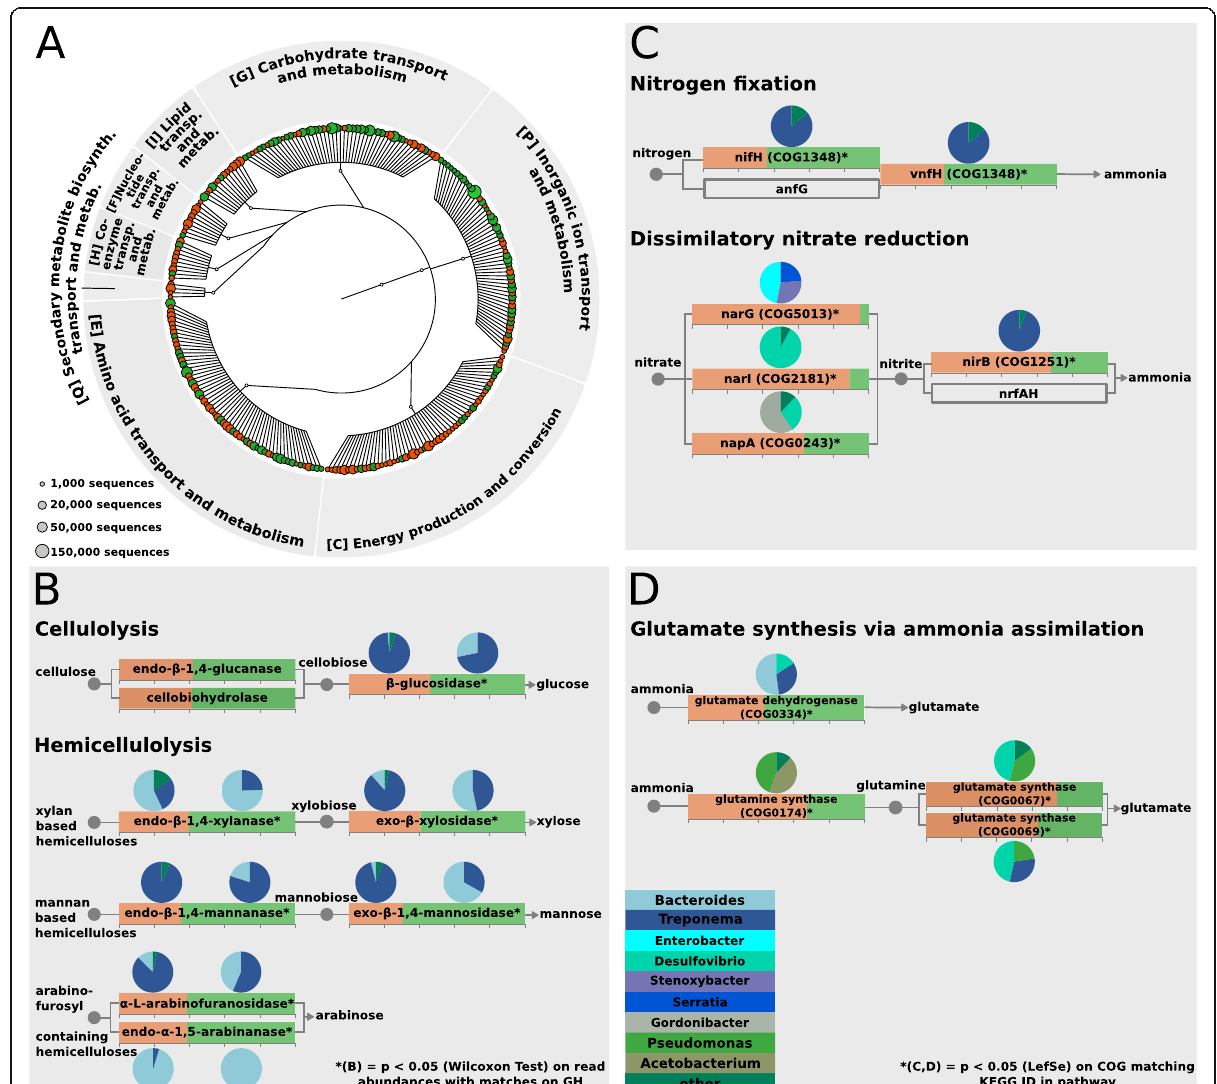
Fig. 4 Differences in the functional content of the bacterial metagenomes of wood-dwelling and foraging species. a Circular dendrogram/ hierarchy of all COGs in the category “ metabolism ” over-represented in wood-dwelling species (green) or foraging species (orange). Circle size at the leafs scales with the abundance of the COG. Over-representation was detected with LefSe [58] ( p < 0.05, q < 0.05, LDA > 2). A Venn diagram visualizing the total number, and the differentially abundant number of functions in each of the five pathways that constitute the category “ metbolism ” can be found in Additional file 1: Fig. S11. b Pathway analysis of cellulose and hemicellulose degradation. Colored boxes of cellulolytic or hemicellulolytic genes indicate proportion of relative abundance of sequences affiliated with wood-dwelling (green) or foraging (orange) species. c Pathway analysis of nitrogen metabolism. Boxes for genes with functions in nitrogen metabolism indicate relative abundance in the two life types. d Pathway analysis of glutamate synthesis. Boxes in c ) and d ) show relative abundance in the two life types of genes with functions in nitrogen/glutamate metabolism. Pie charts show taxonomic association of the gene. All hemicellulolytic genes were over- represented in the wood-dwelling species. Also, a nitrogenase was enriched in the wood-dwelling species, while in the foraging species,